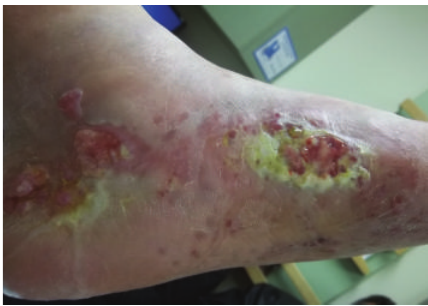
Figure 1: Pretreatment: 5 × 5 cm ulcer on the medial left foot emanating a serosanginous discharge and similar ulcer present posteriorly along with blistering satellite lesions on the plantar surface of the foot.